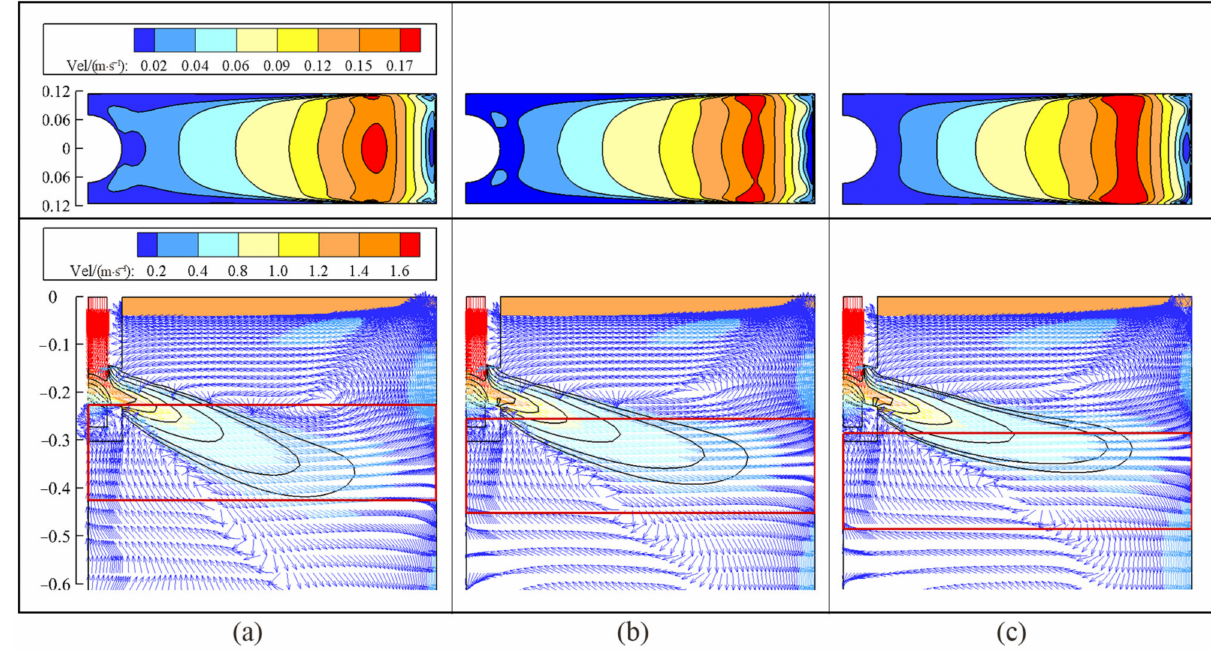
Figure 12. Molten steel flow characteristics in the mold with different positions of the ruler EMBr: ( a ) H 1 = 225 mm, ( b ) H 2 = 255 mm, and ( c ) H 3 = 285